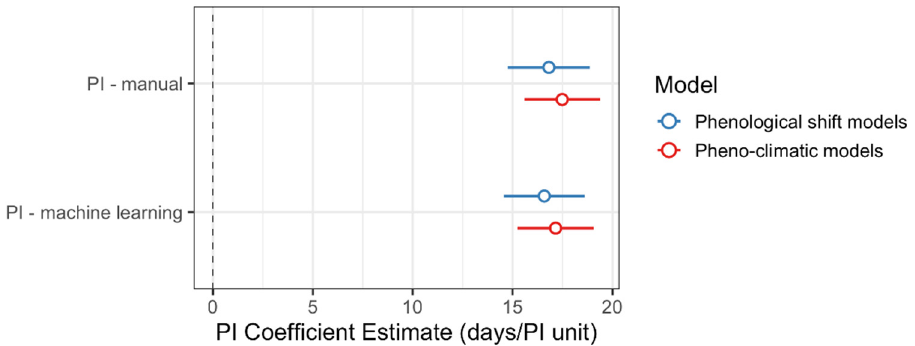
Figure 6. Estimates for the rate of phenological progression (in days/phenological index unit) of Streptanthus tortuosus as measured by the coefficient of the phenological index (PI) from linear regression models designed to detect temporal shifts in flowering date and sensitivity of flowering date to climate. The 95% confidence interval for each estimate can be found in Tables 3 and 4.